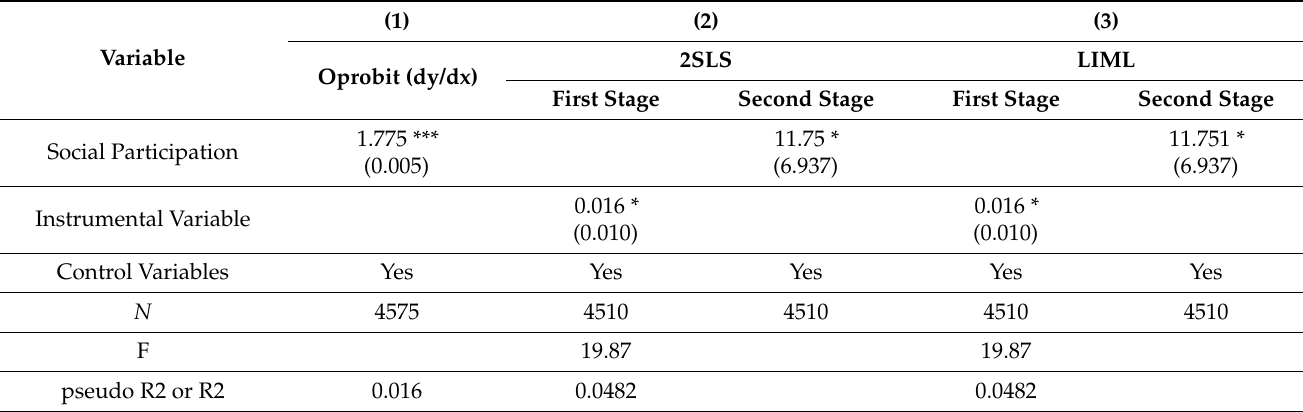
Table 11. Instrumental variable